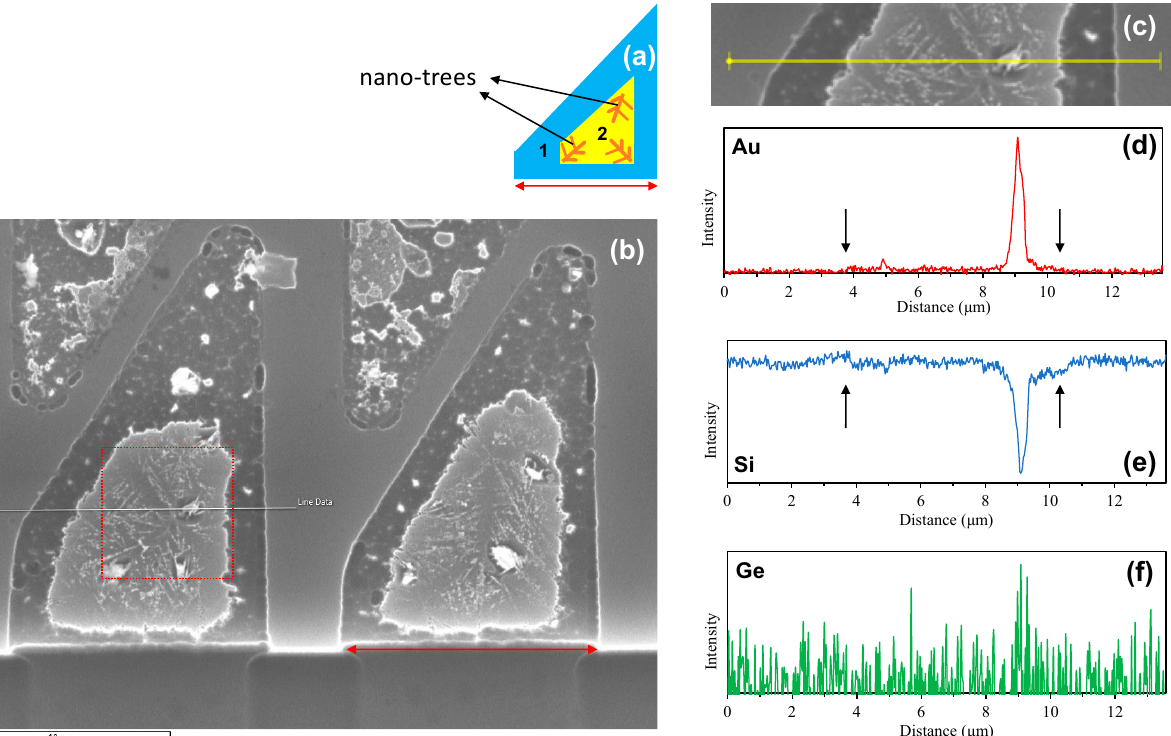
Figure 3. ( a ) Plan-view schematic of the sample with a small opening (shown by a red double arrow) with two regions: (1) dark outer and (2) bright inner regions that have nano-trees. ( b ) Plan-view SEM micrograph of micro-crucibles with a small opening showing the formation of nano-trees in region 2. The white line is an EDS line scan trajectory, cropped and realigned in ( c ). The dotted red box is a region of interest that will be analyzed later in an AFM analysis. The corresponding EDS line scan spectra of Au, Si, and Ge species are shown in ( d ), ( e ), and ( f ), respectively. The resulting EDS spectra indicate the presence of residual Au species in the